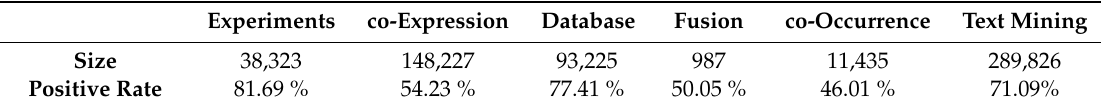
Table 3. Validation of human protein–protein interactions in STRING [7].